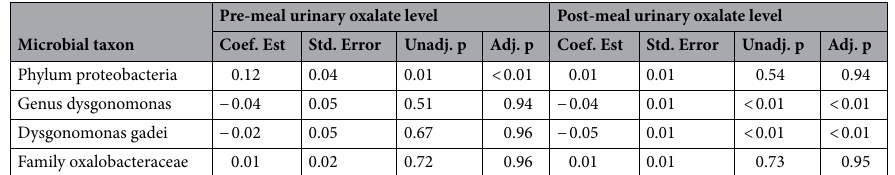
Table 1. Microbial taxa associated with pre/post-dietary urinary oxalate levels in untreated controls. The estimated regression coefficients, standard errors, and unadjusted/adjusted p-values for the effect of the relative abundance of individual microbial taxa with centered log-ratio transformation in fitted mixed effect models. Analysis adjusted for age, gender, ethnicity, BMI, and calcium level.